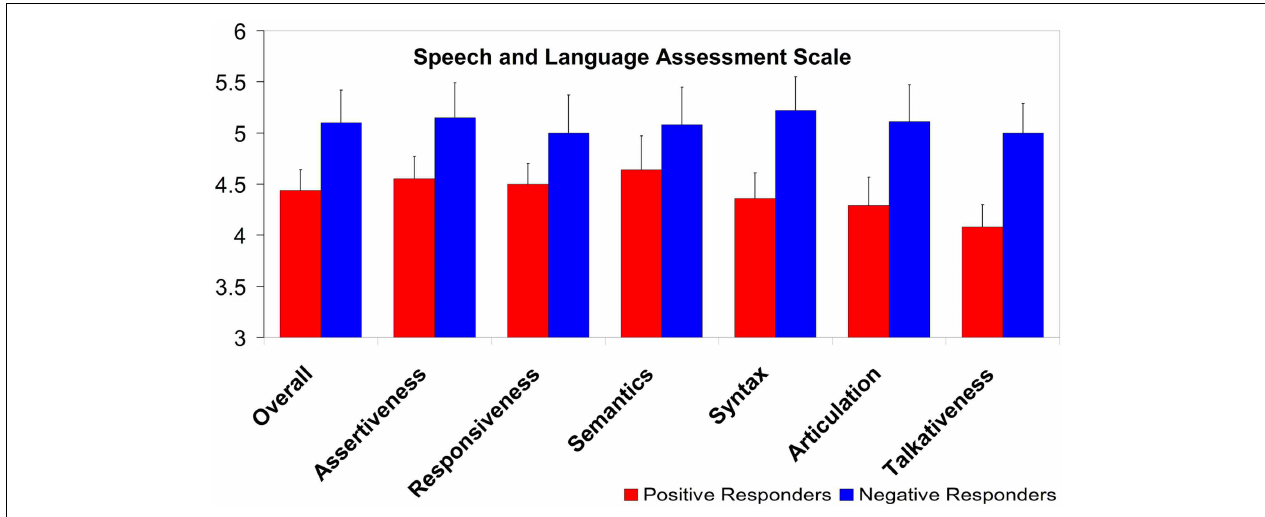
FIGURE 8 | Group ratings on the Speech and LanguageAssessment Scale, overall and per subscale. A score of “4” corresponds to parents rating their child’s language performance as equal to their child’s peers; higher scores reflect better language ratings. (Error bars are one standard error from the